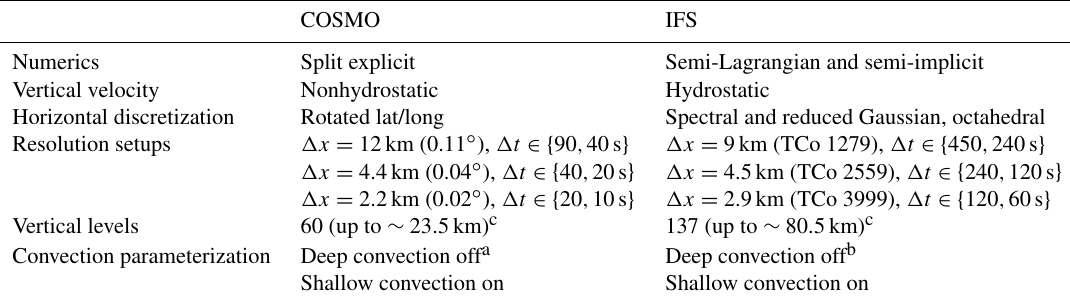
Vertical levels Convection parameterization Deep convection off a Deep convection off b Shallow convection on Shallow convection